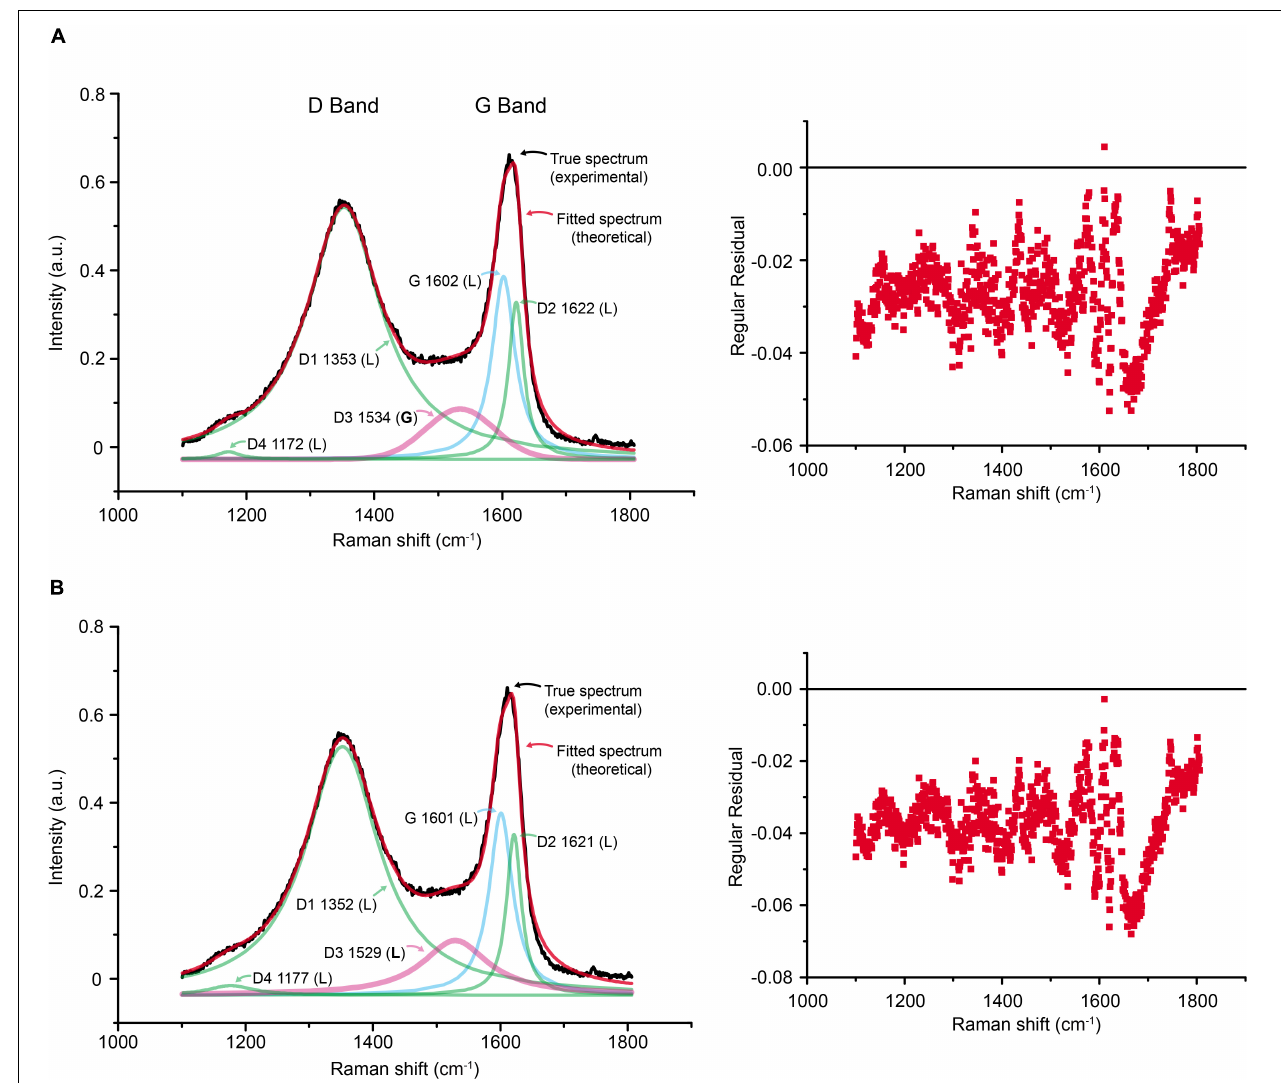
FIGURE 9 | Comparison of the two deconvolution methods. (A) The method of Sadezky et al. (2005) adopted in this study. (B) The method of Lahfid et al. (2010), which designated Lorentzian to D3 band (a pink curve). Note that overall regular residual is smaller in the first method. The numbers in each label of band are central position in the Raman shift; L and G in parenthesis denote Lorentzian and Gaussian distributions, respectively.